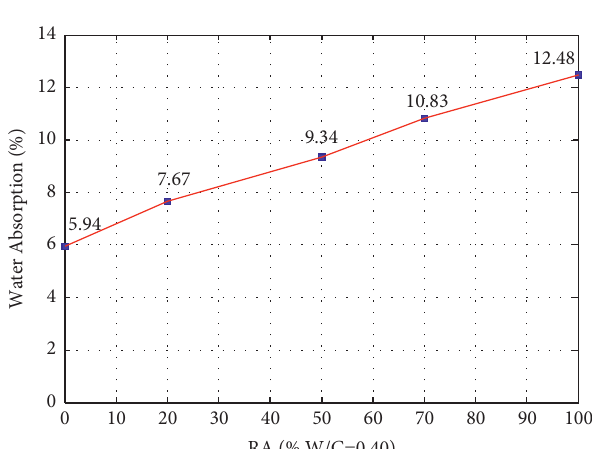
Figure 9: Compressive strength-RA relationship.